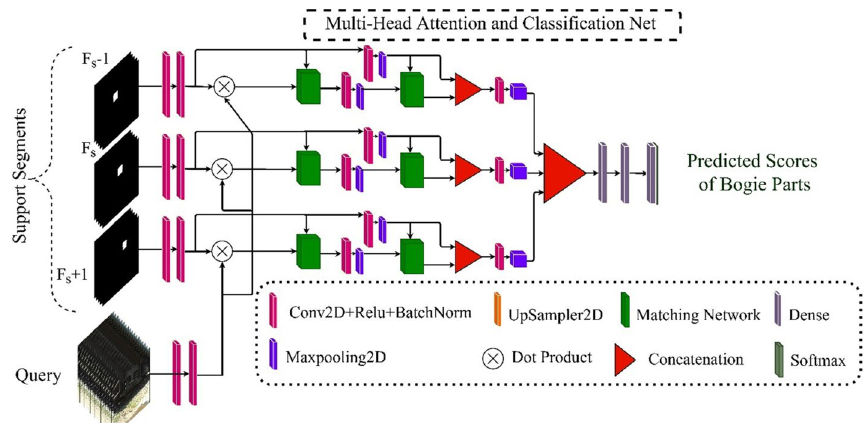
Fig. 4 The proposed cascaded feature matching module with multi head self-attentions for accurate tracking of bogie part position and